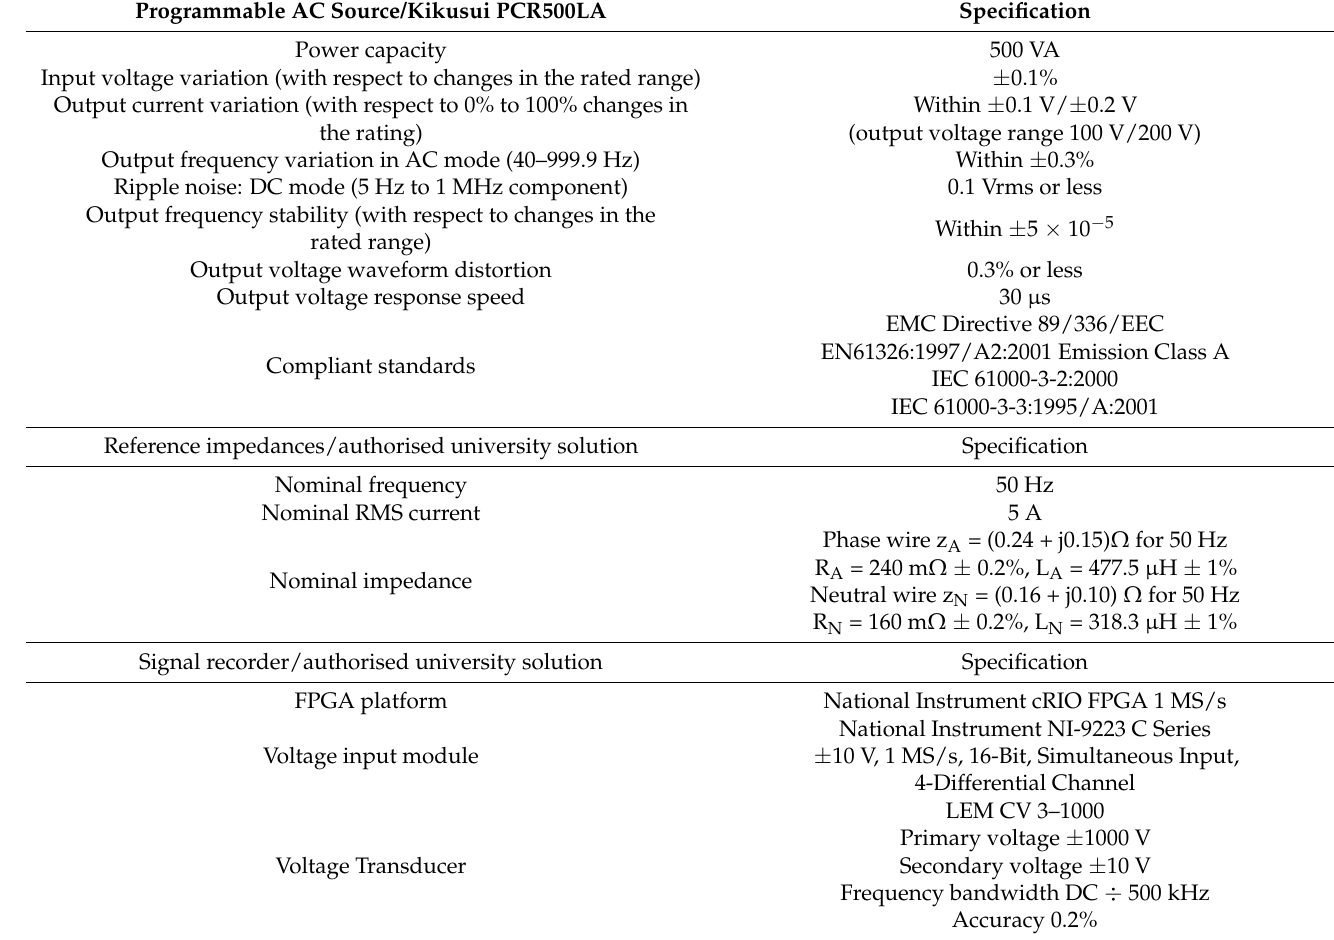
Table 1. Specification of the hardware components of the laboratory test